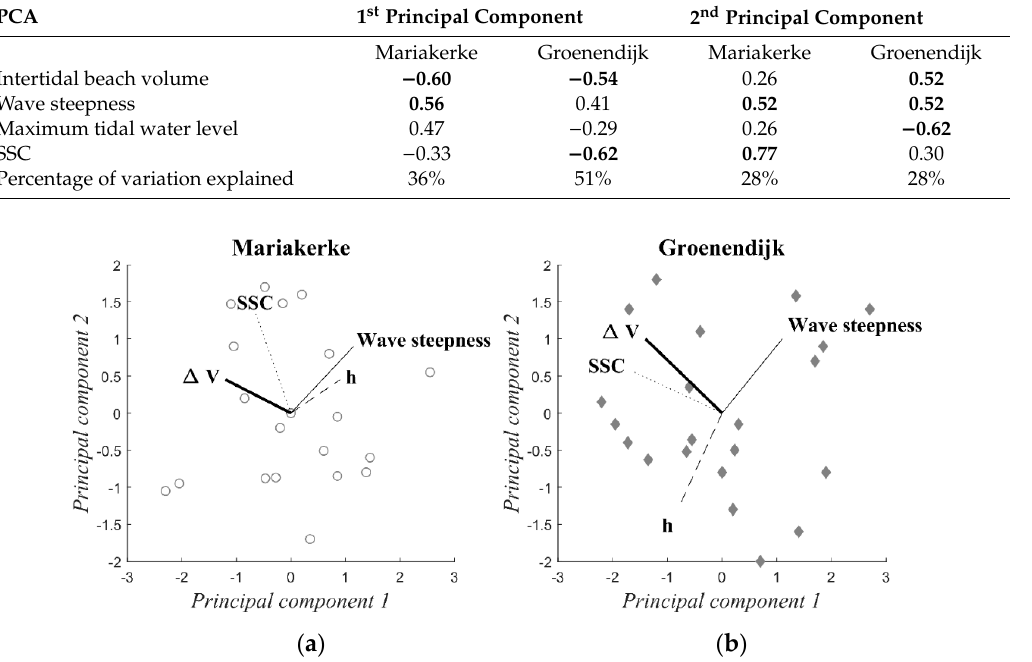
Figure 8. A PCA biplot between volume change ( Δ V) and hydrodynamic forcing factors: wave steepness, maximum tidal water level (h), and SSC for Mariakerke (a) and Groenendijk (b). Table 5. Correlations between daily intertidal beach volume change, daily averaged wave steepness, maximum water level, daily averaged SSC, and the first two principal components for Mariakerke and Groenendijk. High correlations are in bold (>0.5). PCA